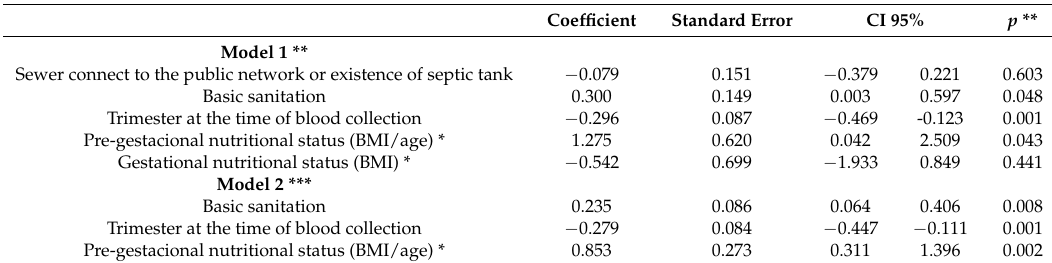
Table 4. Models of multiple linear regression for variable serum retinol levels response * according to the explanatory variables.